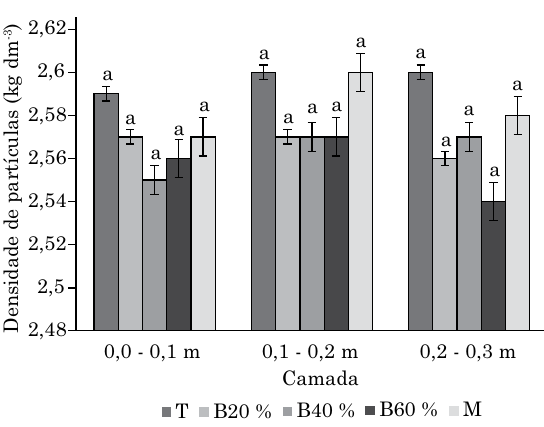
Figura 3. Densidade do solo, com os erros da média, para as áreas sob cultivo de figo e mata secundária (T - Testemunha; B20 % - Biofertilizante 20 %; B40 % - Biofertilizante 40 %; B60 % - Biofertilizante 60 %; e M - Mata nativa). Médias seguidas pela mesma letra na camada não diferem pelo teste de Dunnett